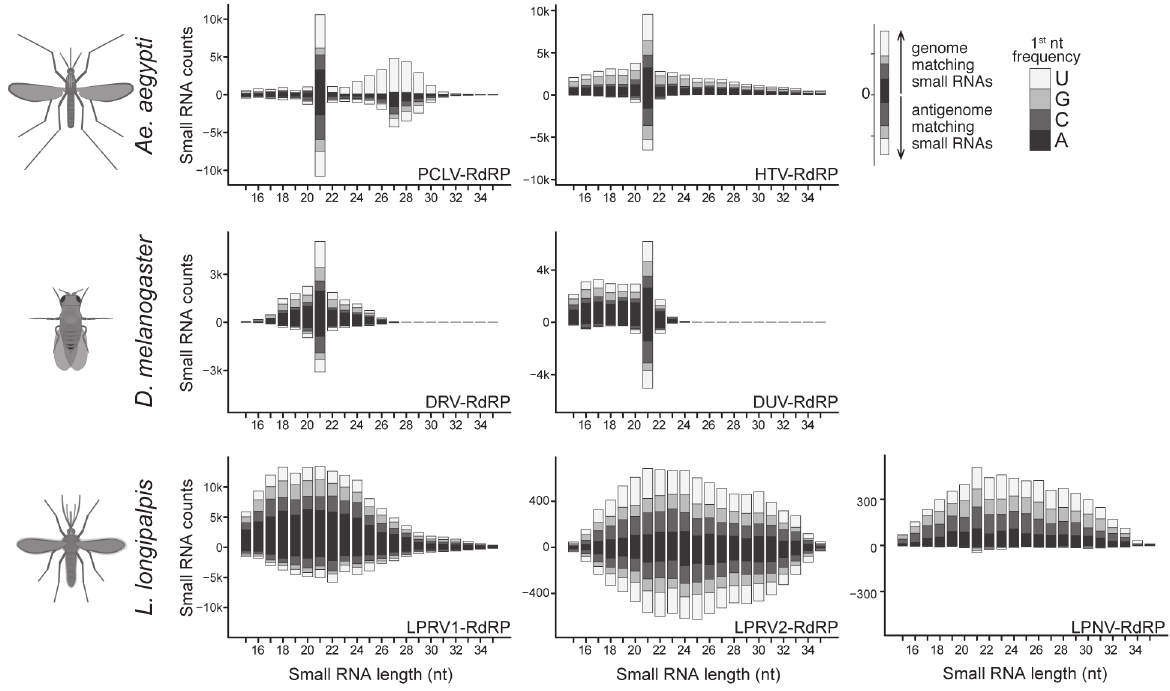
Figure 3 - Profiles of virus-derived small RNAs in dipteran insects. Viral RNA can be recognized by different antiviral surveillance mechanisms, thus generating specific virus-derived small RNA profiles during infection. These distinct patterns can be analyzed and provide extensive information about their source and biogenesis, such as the activation of siRNA (e.g. PClV, HTV, DRV and DUV) and piRNA (e.g. PCLV) pathways. Even a virus-derived small RNA profile consistent with RNA degradation (e.g. lutzomyia Piaui reovirus 1 (lPRV1), lutzomyia Piaui reovirus 2 (lPRV2) and lPNV) can be indicative that the virus escapes RNAi during infection. Adapted from Aguiar et al.